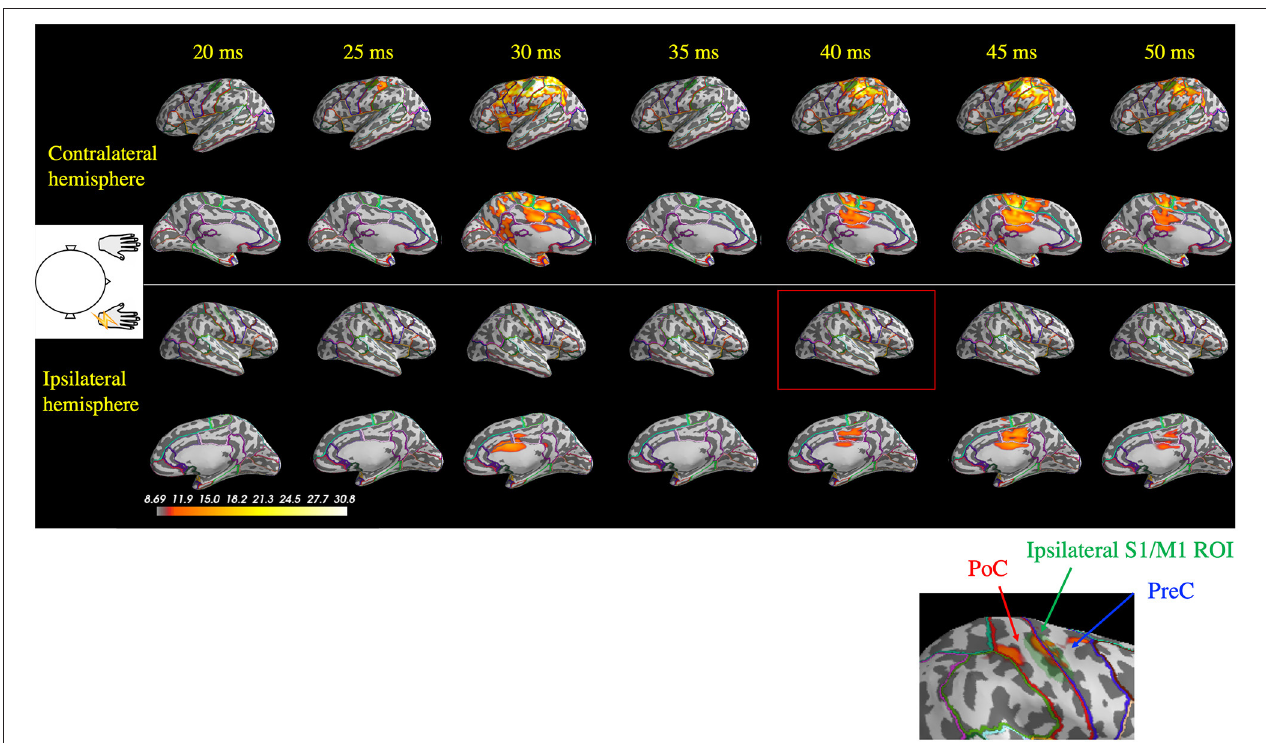
FIGURE 3 | Spatiotemporal distribution of the estimated cortical activity that generated the somatosensory-evoked field following right median nerve stimulation in one patient (Patient 2). Ipsilateral activity (right hemisphere) at around 40ms (red rectangle) was observed exactly in the ipsilateral S1/M1 region of interest (ROI; green shaded area, highlighted in the inset figure). At 45ms, contralateral activity remained prominent, whereas the ipsilateral did not. PoC, postcentral gyrus; PreC, precentral